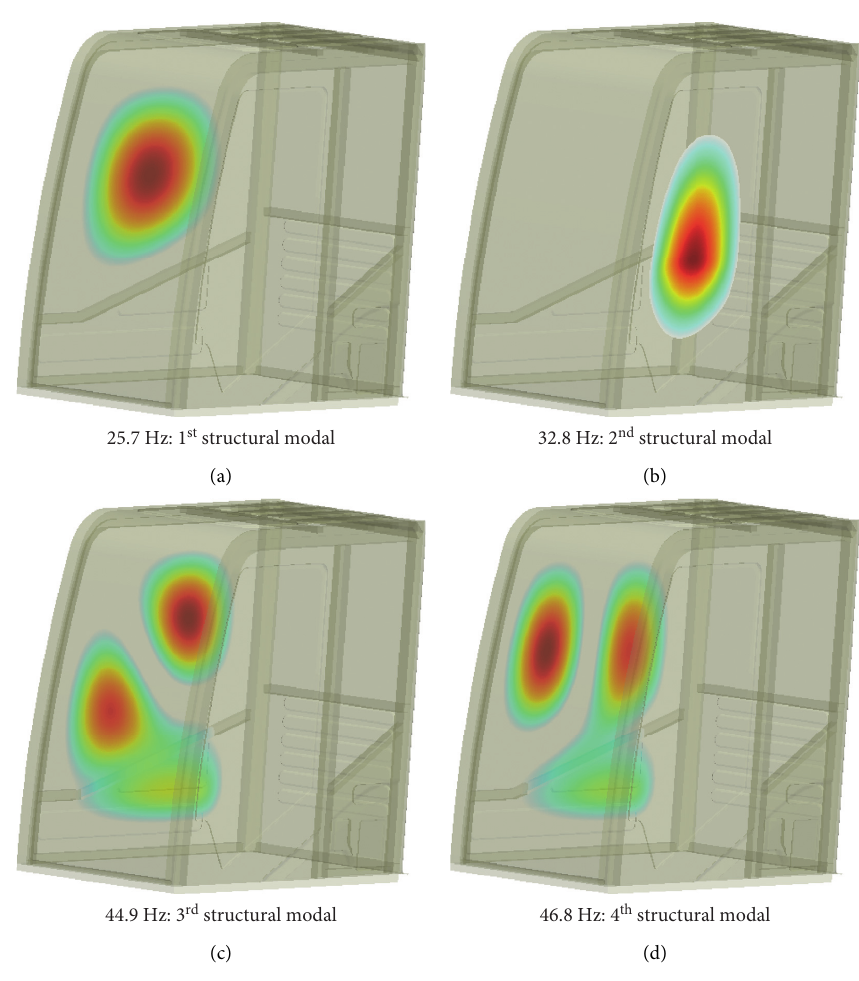
Figure 3: The structural modal of an enclosed cab. (a) 25.7 Hz: 1 st structural modal. (b) 32.8Hz: 2 nd structural modal. (c) 44.9Hz: 3 rd structural modal. (d) 46.8Hz: 4 th structural